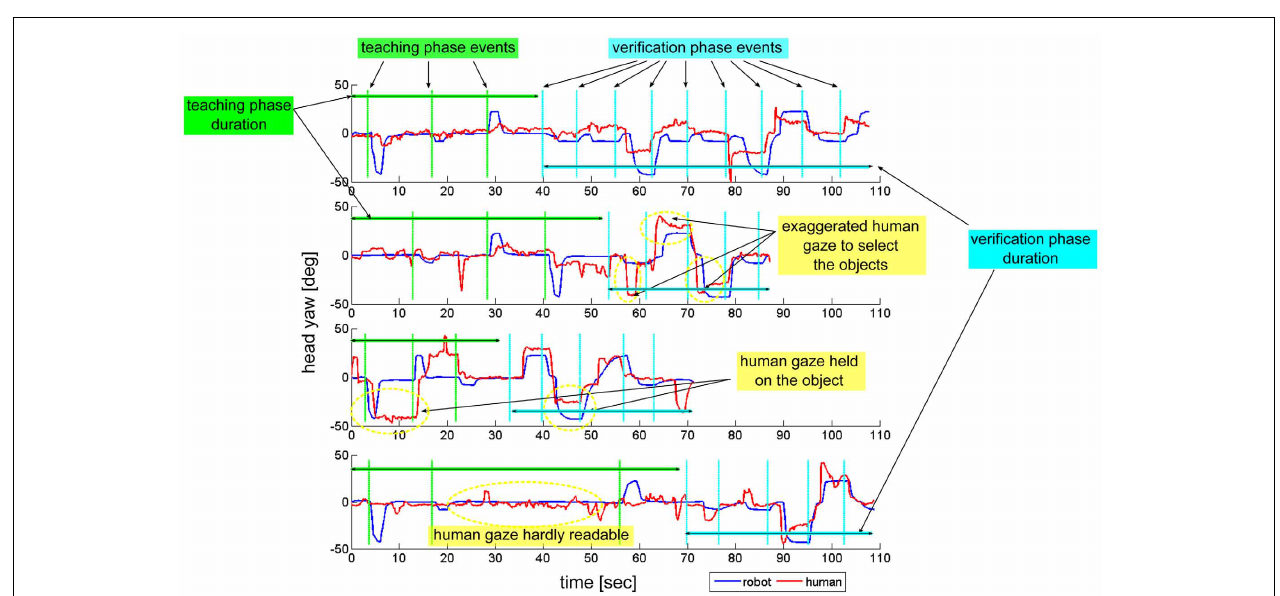
look at one of the objects on the table. The human, if engaged, follows the robot gaze (red line). When both partners look at the same object, the information exchange can take place. In this situation, the human can keep gazing at the object or look back at the robot for a confirmation (dashed lines).